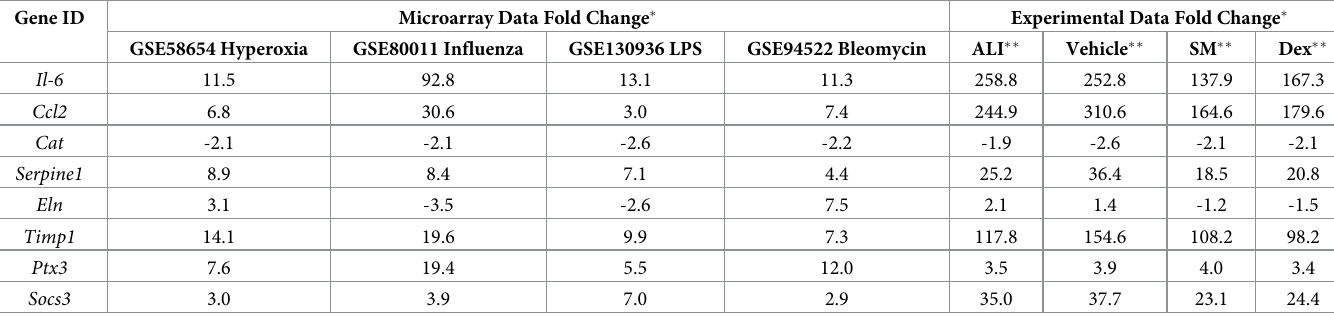
� Expression level data in the experimental groups were normalised to the expression level in healthy mice. Three samples from each experimental group were analysed in triplicate. Data are shown for control groups ALI and vehicle (LPS chellenged mice without treatment and after vehicle administration, respectivelly) and experimental groups SM and Dex (LPS chellenged mice after SM or Dex administration, respectivelly). Il-6 – Interleukine 6, Ccl2 – C-C Motif Chemokine Ligand 2, Cat – Catalase, Serpine1 –Serine Proteinase Inhibitor. Clade E. Member 1, Eln –Elastin, Timp1 – Tissue Inhibitor of Matrix Metalloproteinase 1, Ptx3 – Pentraxin 3, Socs3 – Suppressor of cytokine signaling